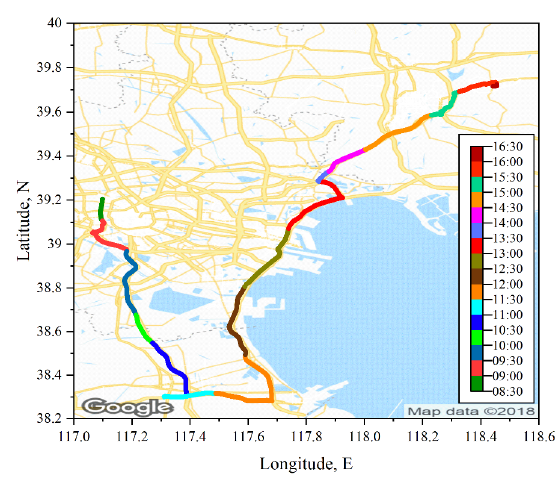
Figure 3. GPS track of the mobile transect from Tianjin to Tangshan on 17 May 2017, colour coded by 30 minutes time intervals (local time) The spatial variability of the extinction coefficients profiles at 532 nm derived from the synergy of lidar and sun